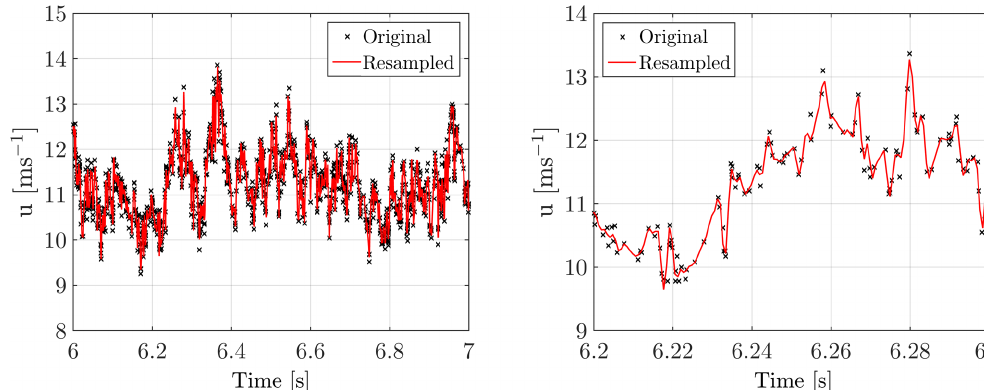
Figure A3. Examples of resampling the raw data u ( t ) uniformly with (cid:104) F S (cid:105) = 1 .